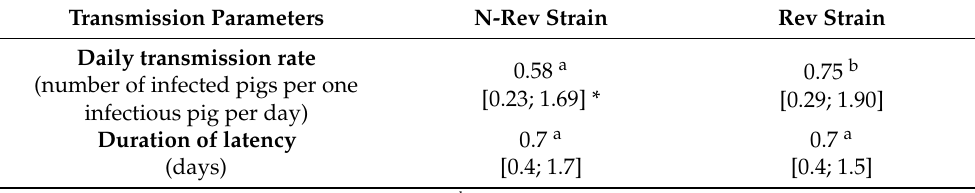
Table 2. Estimation of transmission parameters from Inoc-N-Rev-T#3 inoculated pigs (passage two) to Cont-N-Rev-T#3 contact pigs (passage three) and from Inoc-Rev-T#3 inoculated pigs (passage three) to Cont-Rev-T#3 contact pigs (passage four).